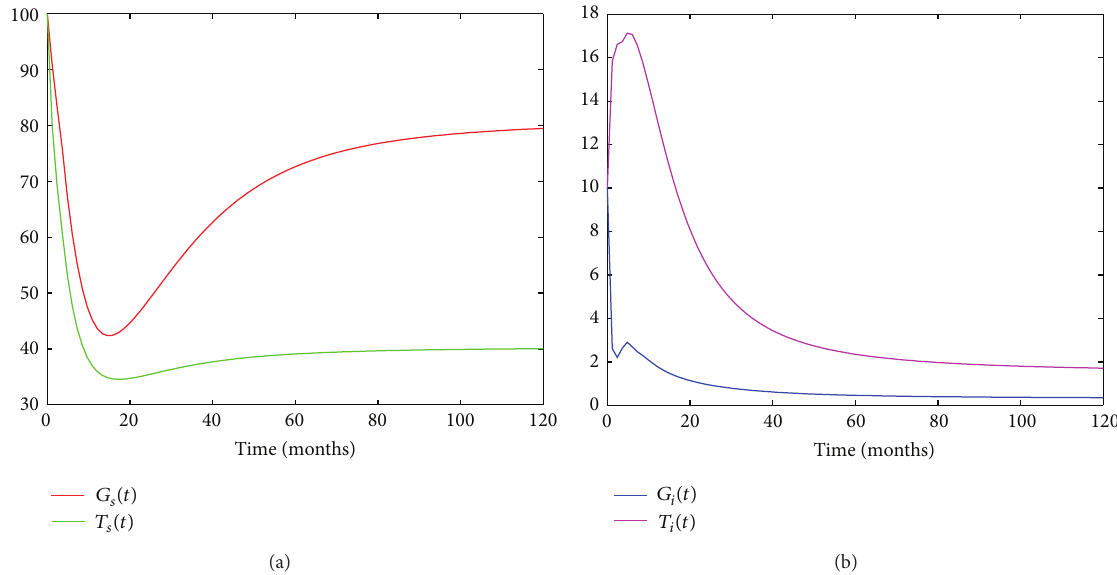
Figure 3: The infection equilibrium 𝐸 ∗ of system (3) is asymptotically stable when 𝜏 = 3 , 𝜔 = 0 , and R 0 > 1 . The initial functions are (100, 10, 100 , and 10) .